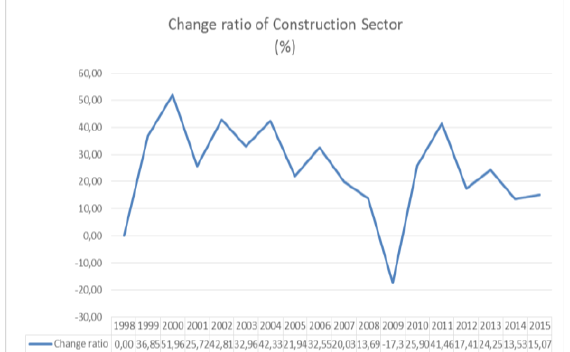
Figure 4. Change Ratio of Construction Sector Source: TUİK database